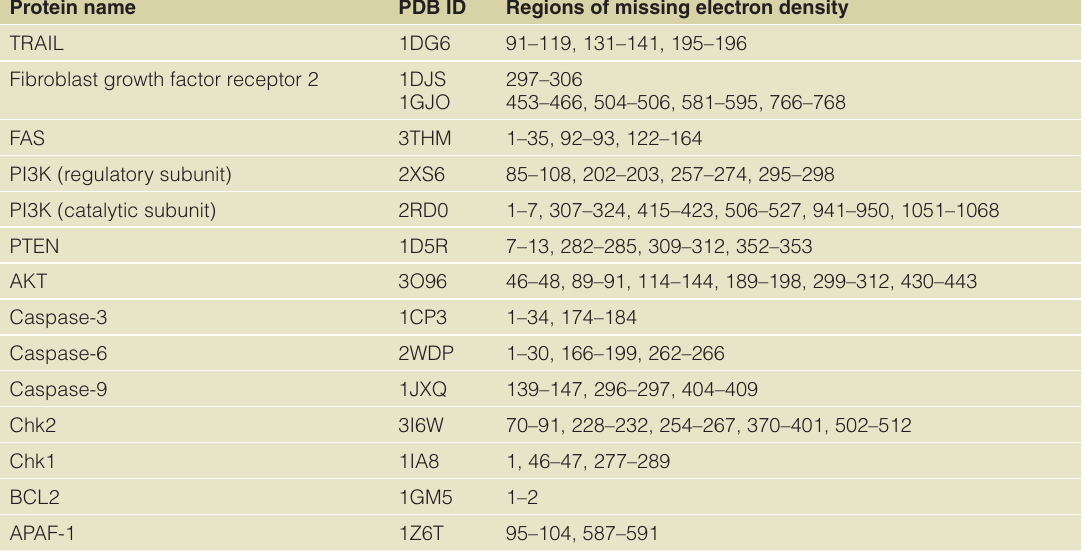
Table 1. Regions of missing electron density in human proteins involved in the p53-mediated apoptotic pathways. Protein name PDB ID Regions of missing electron